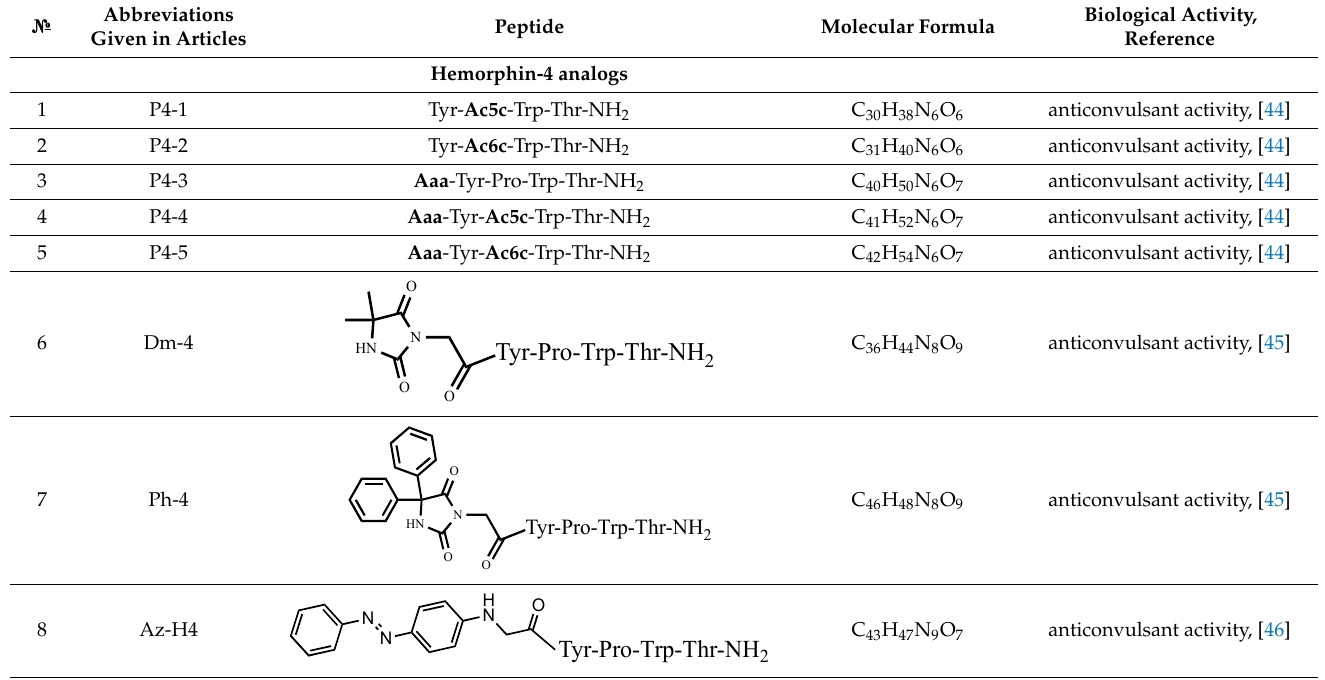
Table 1. Newly synthesized synthetic peptide hemorphin analogs.